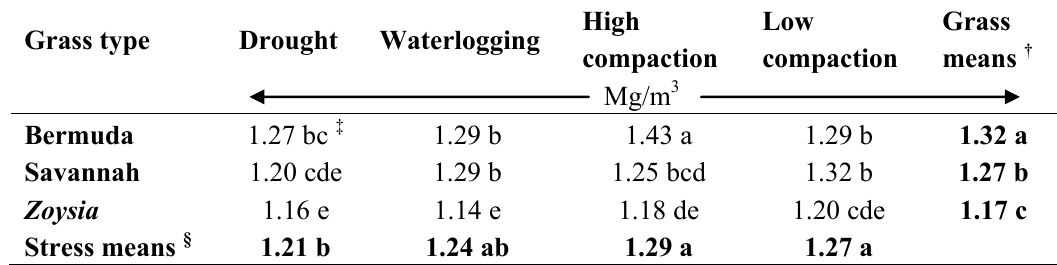
Table 5. Root zone BD under three turfgrass and four applied